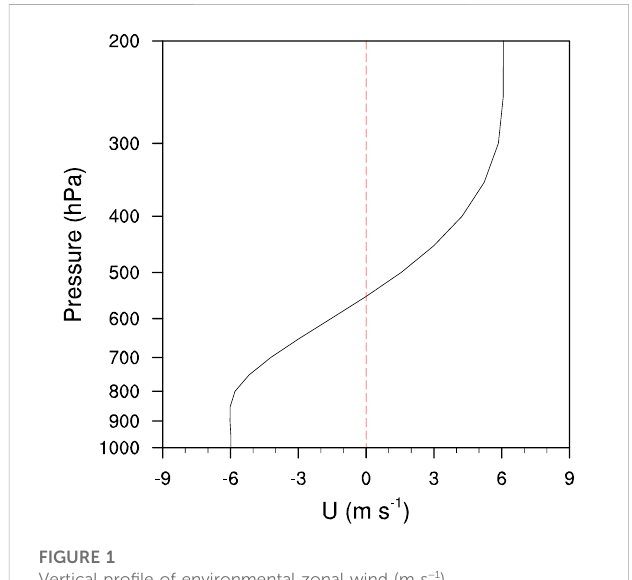
FIGURE 1 Vertical pro fi le of environmental zonal wind (m s − 1